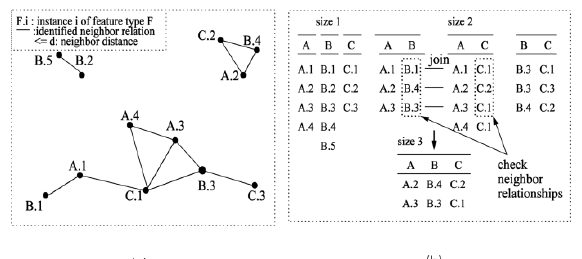
Figure 2. (a) Example dataset. (b) Instance join. (Yoo, J. S. and Shekhar, S.,